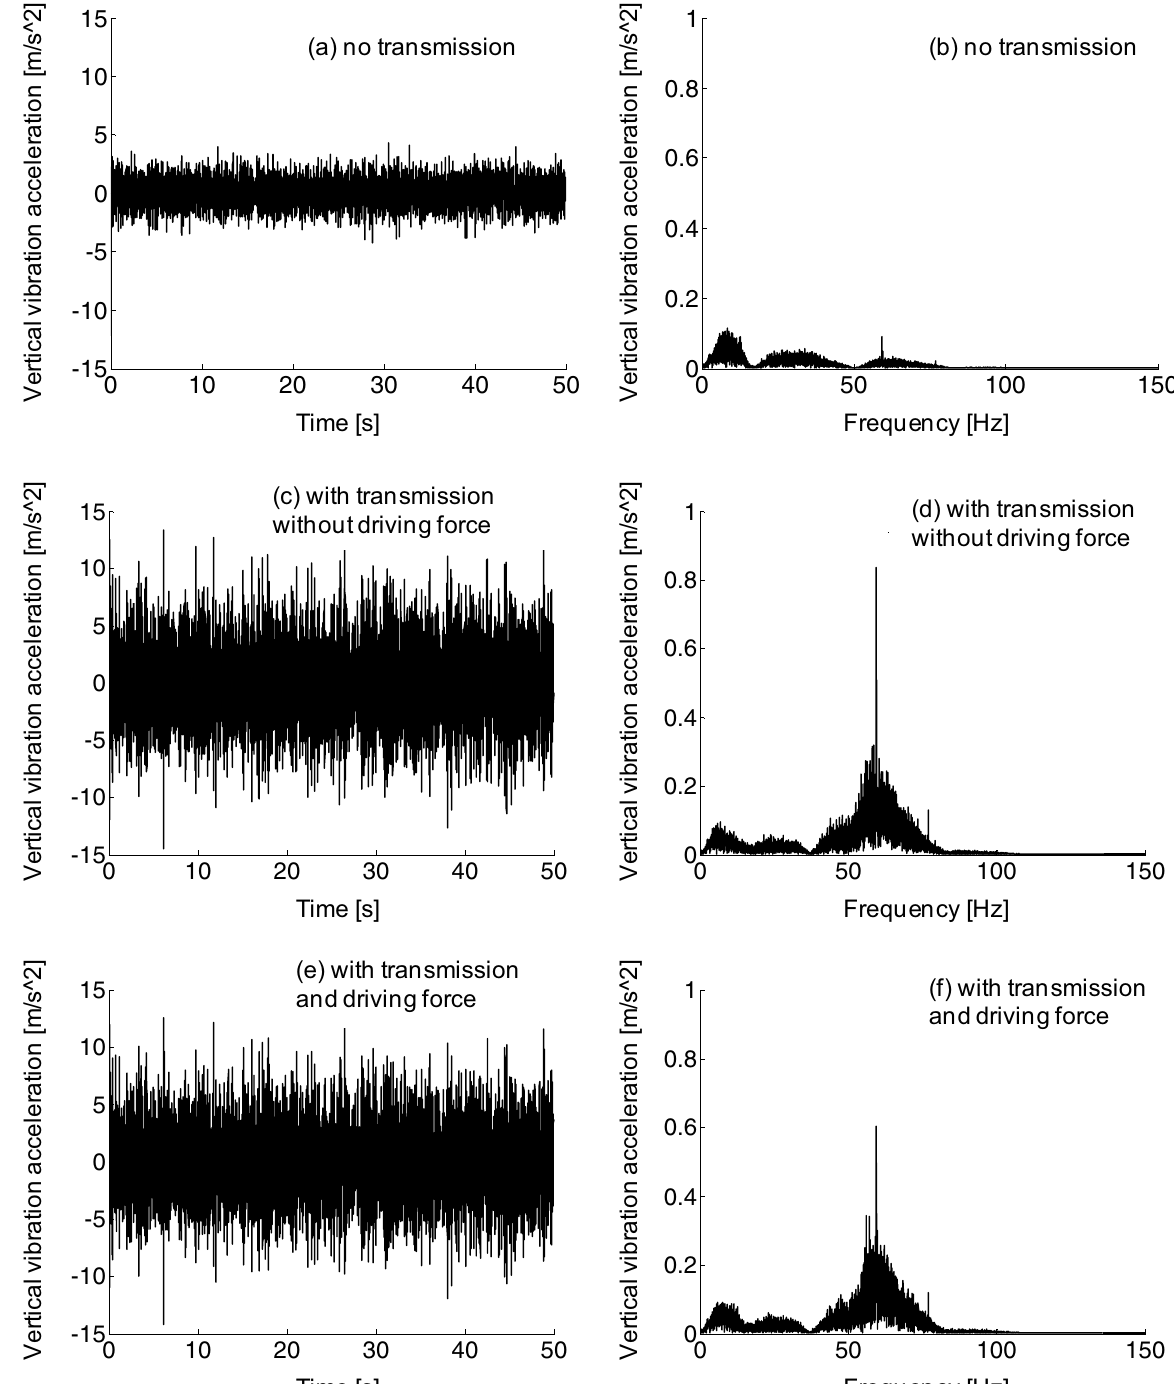
Figure 17. Frame vertical vibration acceleration, (a-b) no transmission, (c-d) with transmission without driving force, (e–f) with transmission and driving